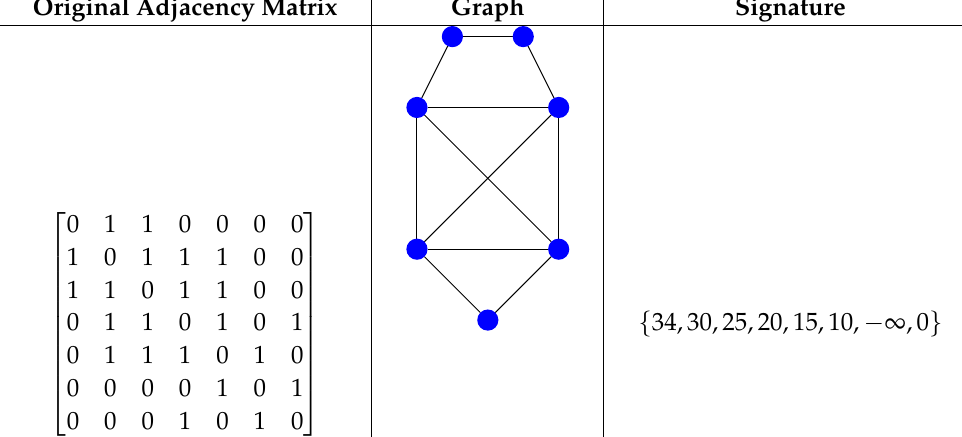
Table A2. Figure 4. Original Adjacency Matrix